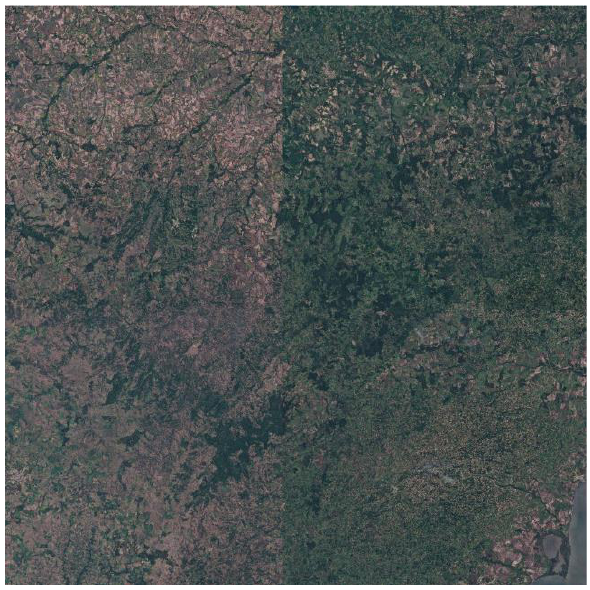
Figure. 13: Seam lines evident between four tiles prior to